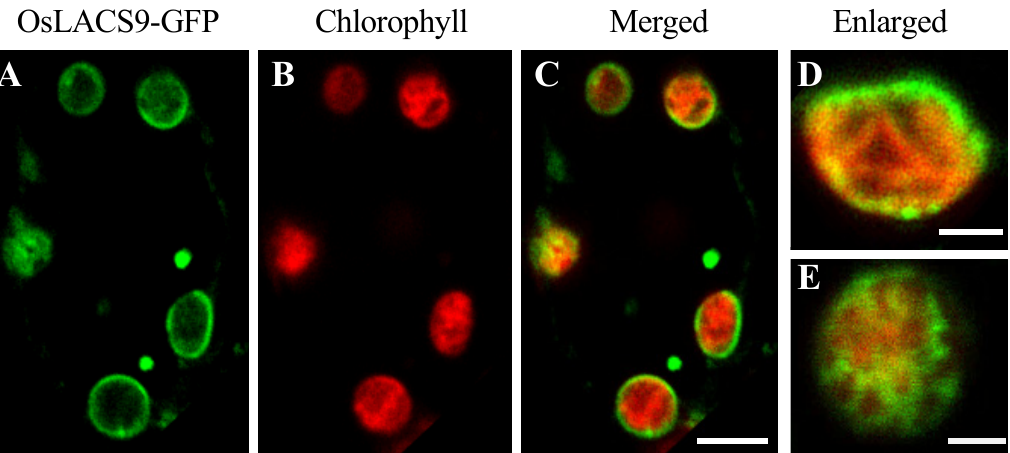
Figure 5. Subcellular localization of LACS9 in leaf mesophyll cells of rice stably expressing OsLACS9-GFP. Confocal fluorescence microscopy images show ( A ) the signal of OsLACS9-GFP, ( B ) the chlorophyll autofluorescence, ( C ) the merged images, and ( D , E ) enlarged images of the chloroplast. Bars = 5 µm.